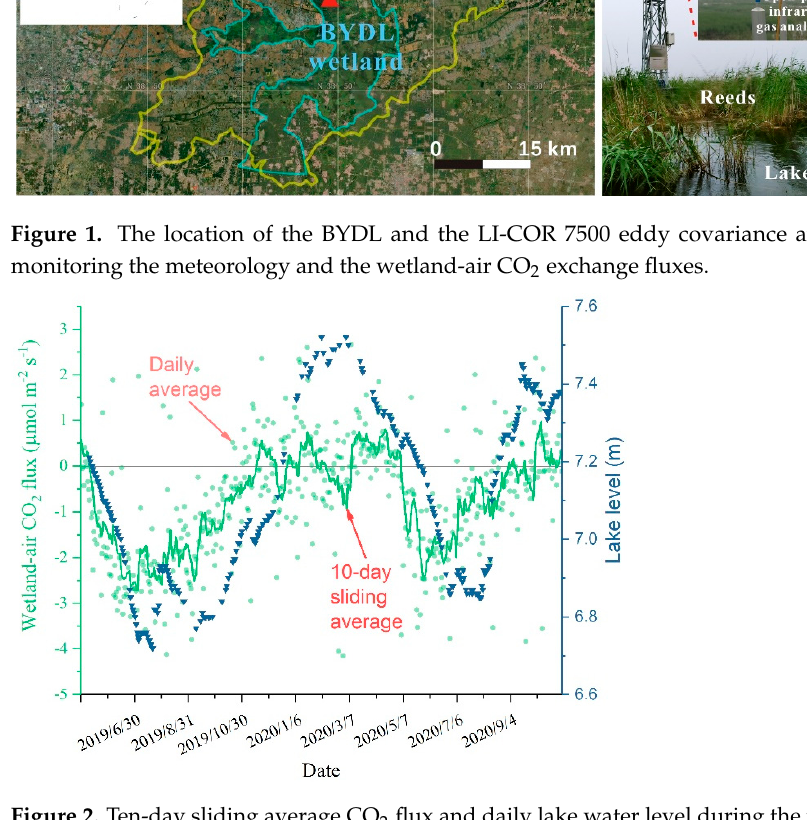
Figure 2. Ten-day sliding average CO 2 flux and daily lake water level during the monitoring period.